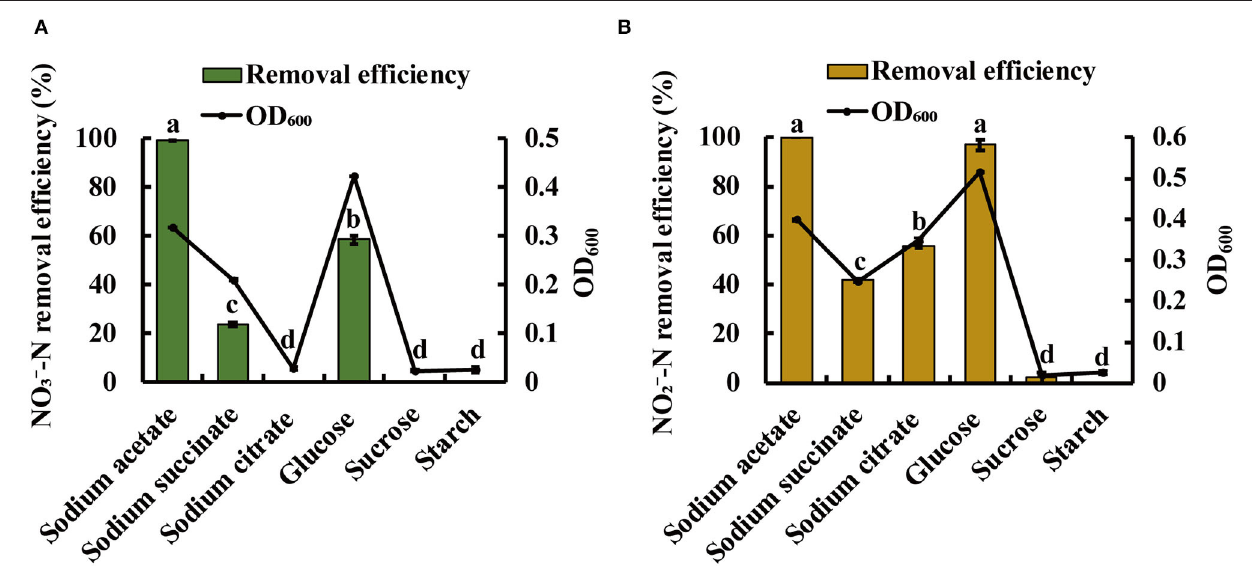
FIGURE 4 | Growth (OD 600 ) and NO − 3 -N and NO − 2 -N removal performance of strain JM10B5a T under various common carbon sources. (A) NO − 3 -N as the sole nitrogen source. (B) NO −